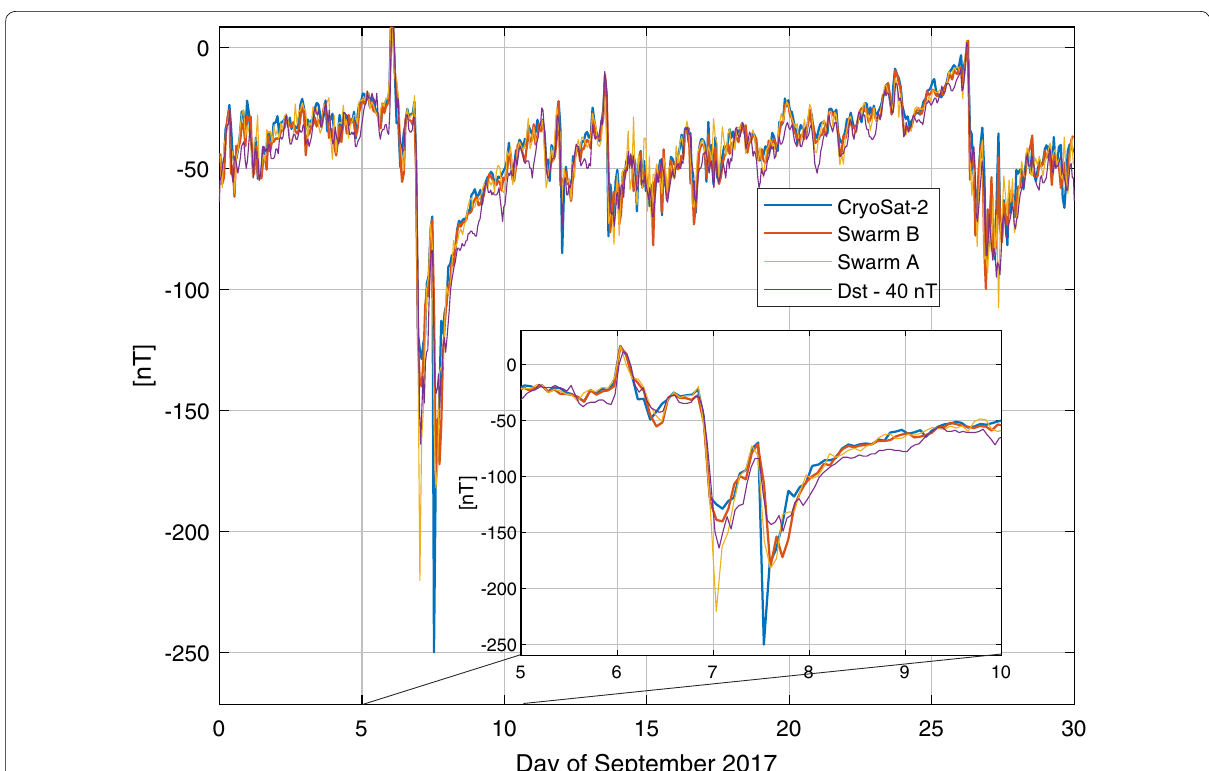
Fig. 8 Signature of the magnetospheric ring‑current for September 2017 as determined from various satellites. For comparison the Dst ‑index 40 nT in order to correct for the well‑known baseline‑instabilities of that index) is also (shifted by −